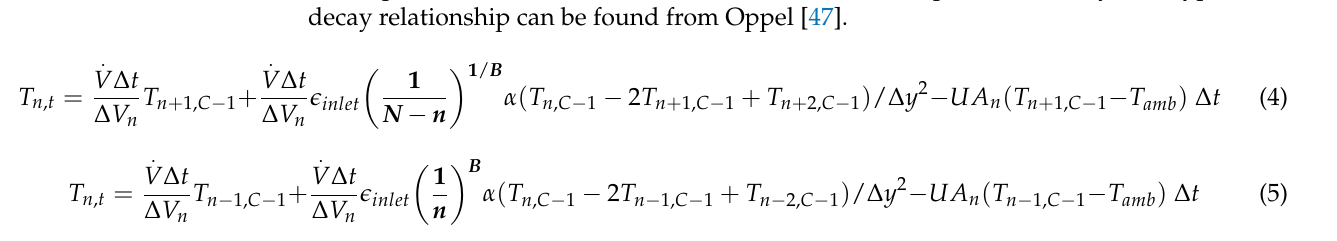
decay. The exponential factor B from the (cid:2035) (cid:3036)(cid:3041)(cid:3039)(cid:3032)(cid:3047) is used in the exponential decay; the hy- perbolic decay relationship can be found from Oppel [47].